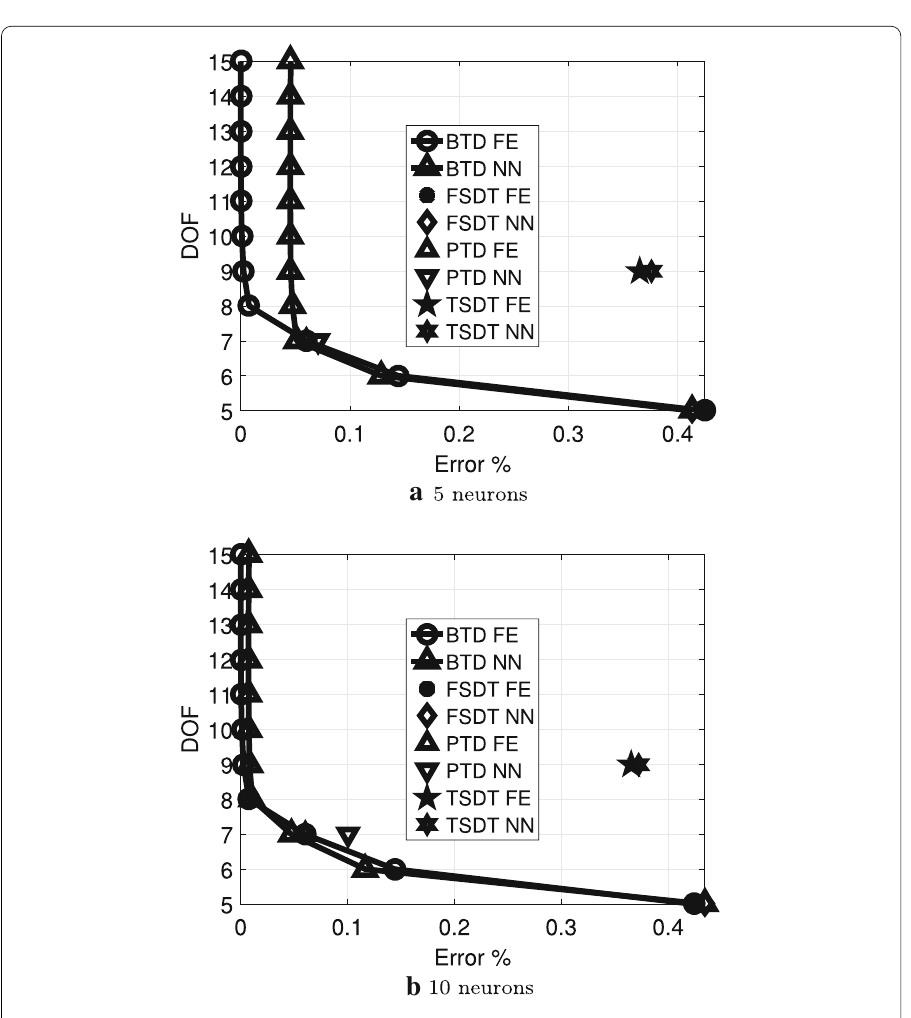
Fig. 5 FE and NN results for 0/90/0, a/h = 100, 10% training sets, one layer, influence of the number of